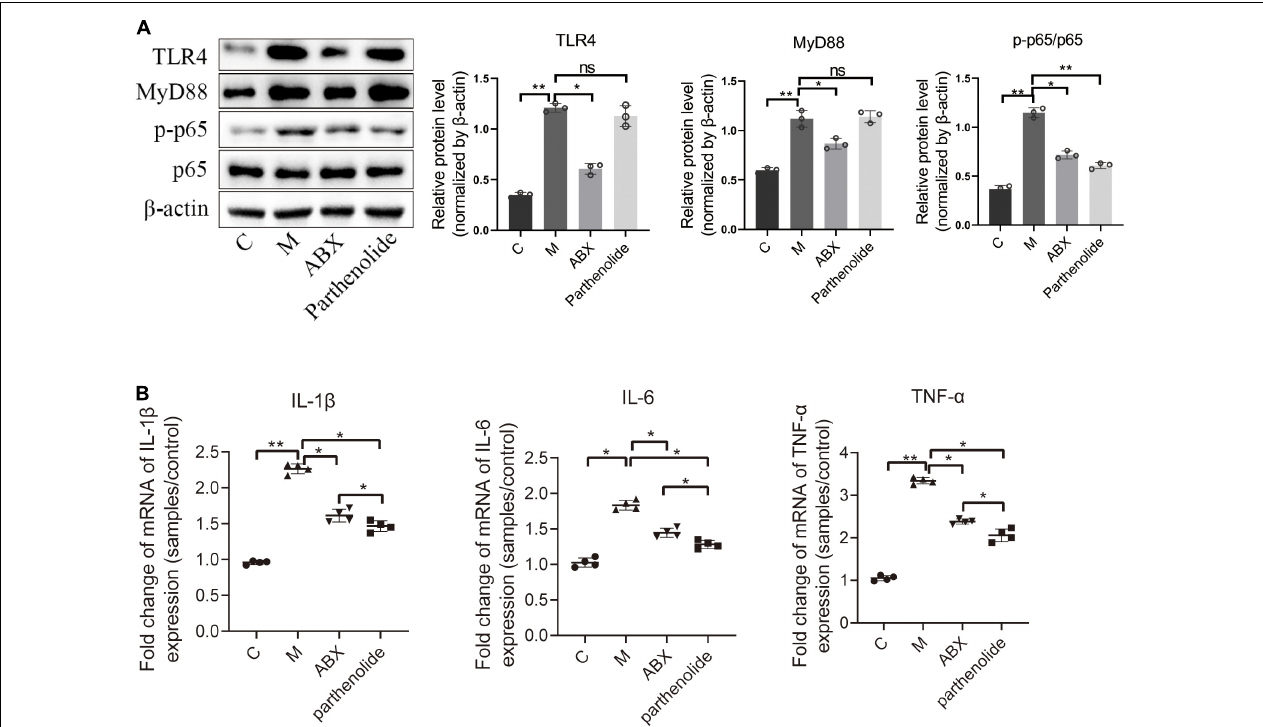
FIGURE 4 | Inflammatory cytokines and key proteins of the NF- κ B signaling pathway were inhibited by ABX and parthenolide in EMS mice. (A) Western blot analysis of TLR4, MyD88, p65, and p-p65 expression in ectopic lesions, β -actin was used as an internal control ( n = 3). The relative expressions of TLR4, MyD88, p65 and p-p65 were quantified by ImageJ. (B) qPCR-based relative expression of IL-1 β , TNF- α , and IL-6 levels in peritoneal fluid from the indicated treatment groups. Data are presented as mean ± SE ( n = 4). Data are presented as means ± SD. One-way repeated-measures ANOVA with Tukey’s test for multiple comparisons, * p < 0.05, ** p < 0.01, and ns,